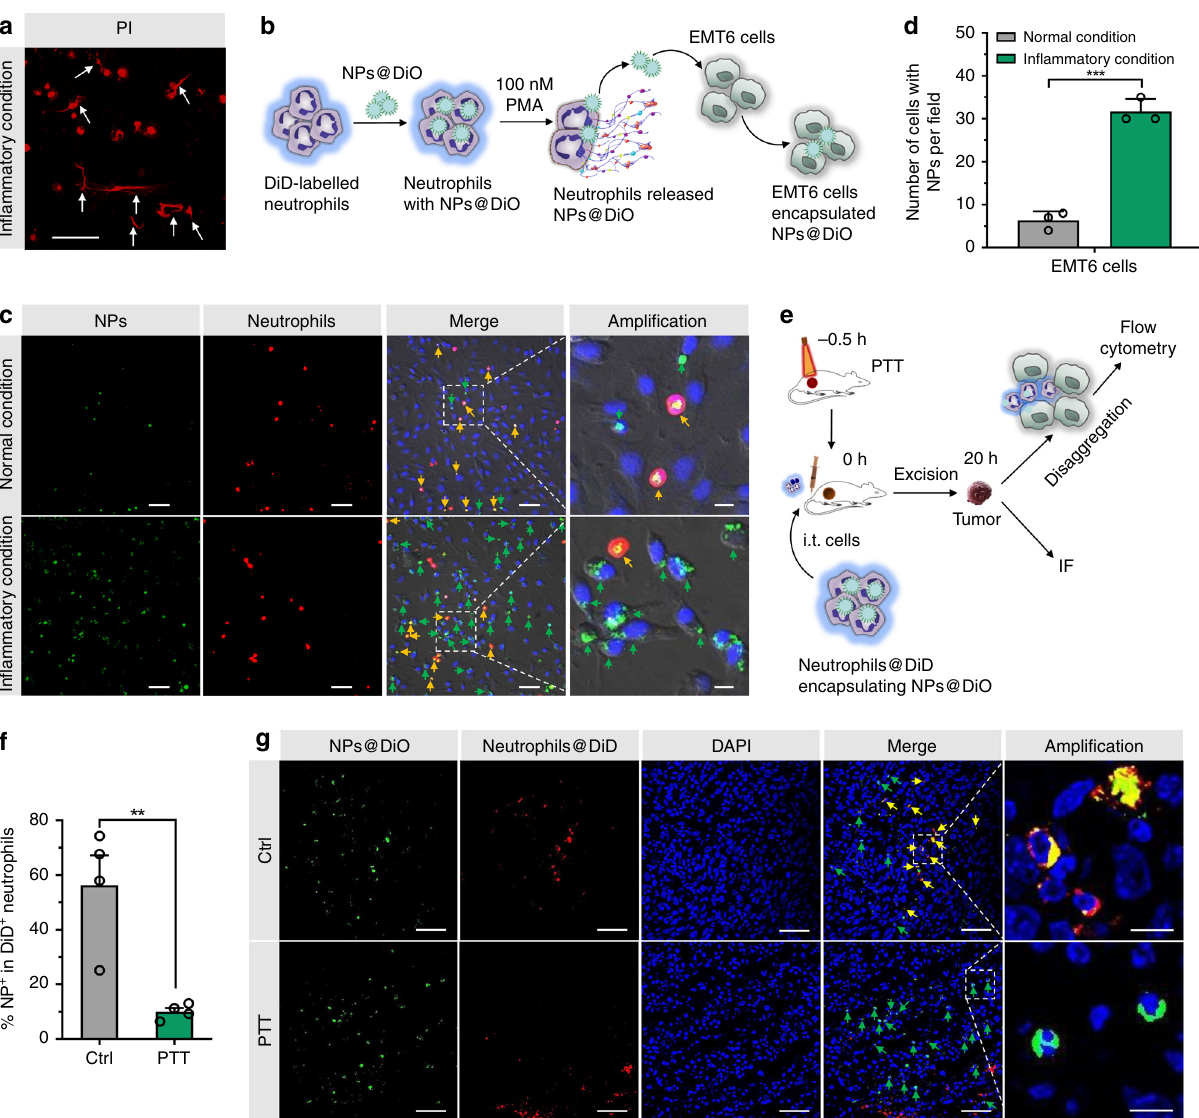
Fig. 6 Tumor cells internalized NPs that were released from neutrophils under in fl ammatory conditions. a Confocal fl uorescent images of propidium iodide (PI)-stained neutrophils cultured under in fl ammatory conditions (100 nM PMA) for 5 h. Scale bar, 50 μ m. Data are representative of two independent experiments. b Work fl ow of neutrophils and EMT6 co-culture assay. DiD-labeled neutrophils were incubated with DiO-labeled PEG- b -PLGA NPs (NPs@DiO) for 1 h. The obtained neutrophils were co-cultured with EMT6 cells followed by nucleus staining and microscopy imaging. c Confocal fl uorescent images of co-cultured EMT6 cells and neutrophils. Yellow arrows indicated neutrophils with NPs and green arrows indicated EMT6 cells with NPs. Scale bars, 10 μ m for the ampli fi cation panels, and 50 μ m for all the other panels. Data are representative of three biological replicates. d Number of EMT6 cells that internalized NPs under in fl ammatory and normal conditions. n = 3 biologically independent samples per group. e Schematic showing analyses of tumors that internalized NPs released from neutrophils in untreated or photothermally treated EMT6 tumors. EMT6-bearing mice were left untreated or were i.v . injected with NPs@PBT on − 12 h and tumors were performed with PTT (40 °C for 5 min) on − 0.5 h. DiD-labeled neutrophils were incubated with DiO-labeled PEG- b -PLGA NPs and intratumorally (i.t.) injected into the mice at 0 h. After 20 h, DiO fl uorescent signals were analyzed by fl ow cytometry and IF. f The percentage of transferred neutrophils containing NPs (de fi ned as NP + DiD + ) was detected by fl ow cytometry. n = 4 mice per group. g DiO signals in transferred neutrophils and EMT6 tumor cells were analyzed by IF. Yellow and green arrows indicated NPs@DiO that were co- localized and not co-localized with neutrophils, respectively. Scale bars, 10 μ m for the ampli fi cation panels, and 50 μ m for all other panels. Data are representative of three biological replicates. Data are shown as mean ± SD ( d ) or mean ± SEM ( f ), and analyzed by unpaired two-tailed Student ’ s t -test. ** P < 0.01, *** P < 0.001. Source data are provided as a Source Data fi